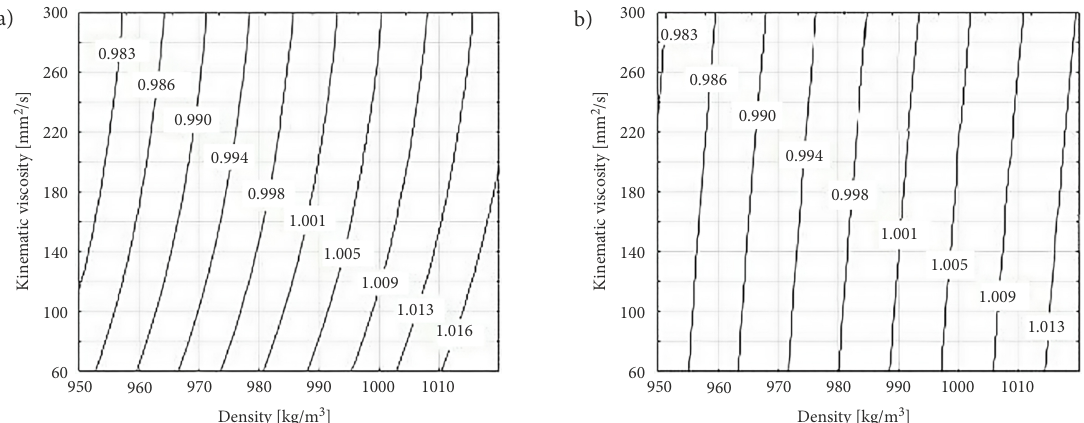
Figure 10. Multivariate characteristics of relative BSFC change in ChN 26.5/31 engine working with residual